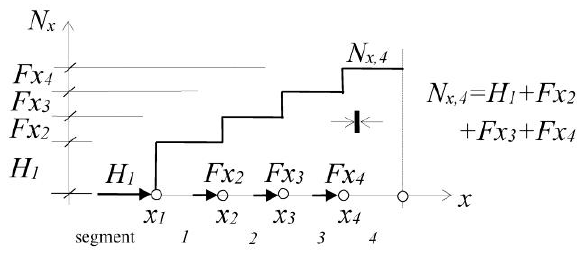
Figure 7. Effect of Fx i on N x,i.